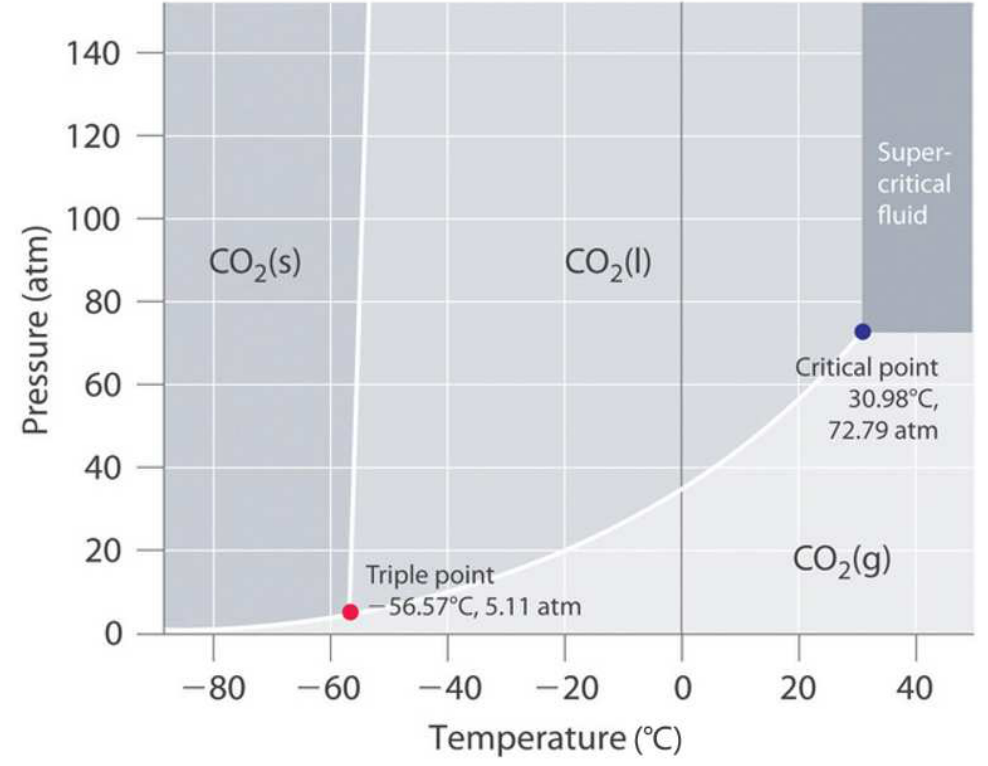
Figure 1. Pressure—temperature phase diagram for CO 2